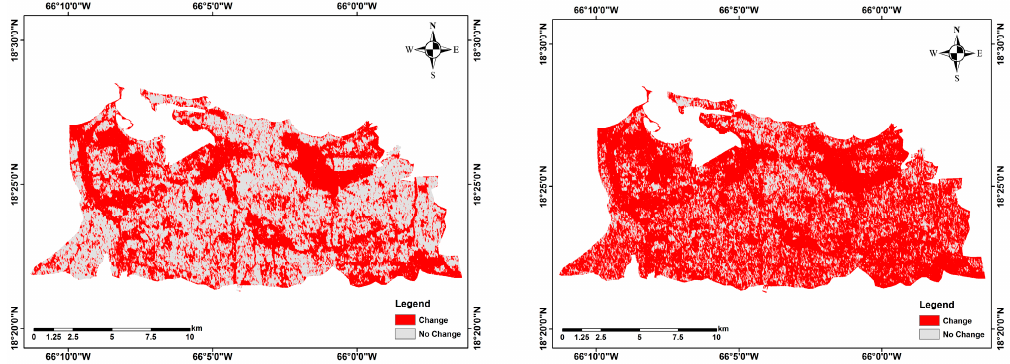
Figure 4. San Juan, Puerto Rico Coherence image classified into change and no change showing images before (11 August 2017, left ) and after (28 September 2017, right ) hurricane Maria.